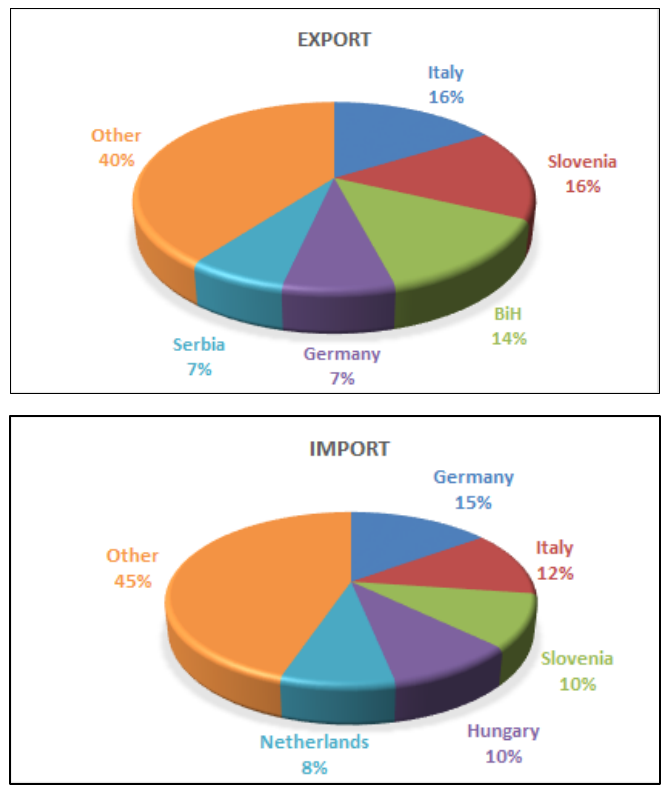
Figure 3. The most important export and import markets of Croatia in agri-food products in year